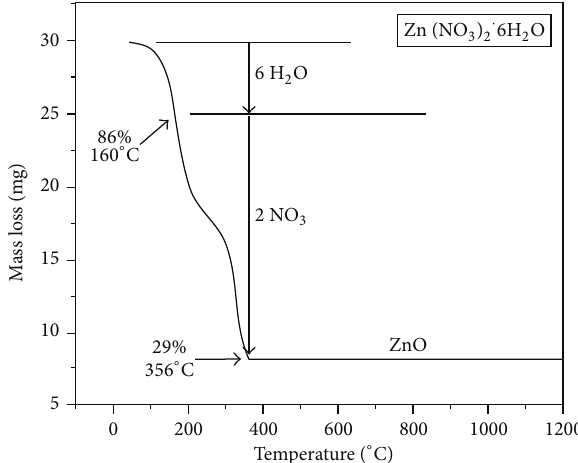
Figure 2: Thermogravimetric analysis (TGA) curve of precursor Zn(NO 3 ) 2 ⋅ 6H 2 O.